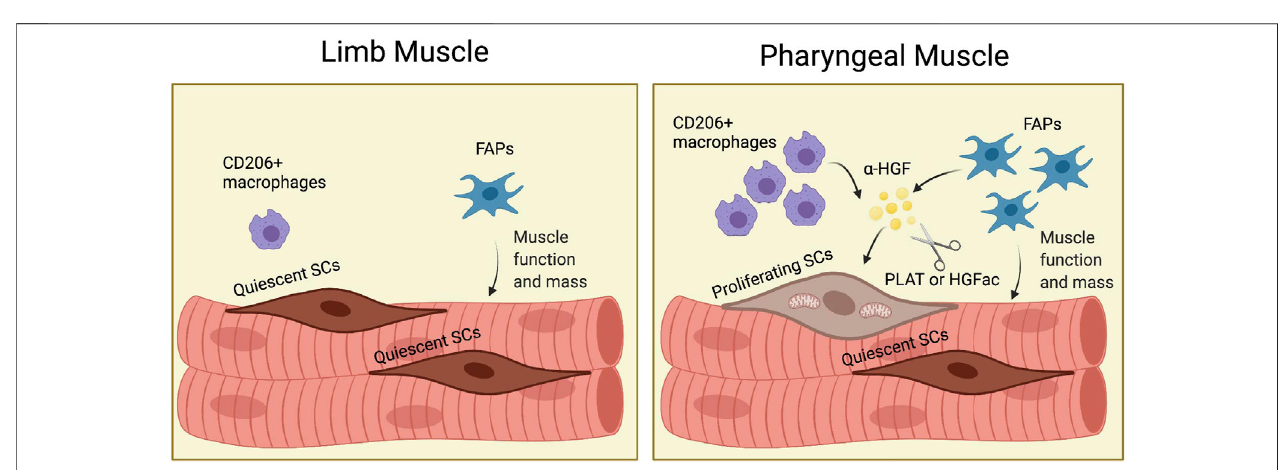
FIGURE 8 | (Graphic abstract). FAPs induce proliferation of pharyngeal satellite cells by HGF and maintain pharyngeal muscle mass and function. In pharyngeal muscles, the increased number of CD206 + macrophages and fi broadipogenic progenitors (FAPs) secrete HGF. HGF is converted to the active form ( α -HGF) by tissue- type plasminogen activator (PLAT) or HGF activator (HGFac). Therefore, FAPs mediate proliferation of SCs in pharyngeal muscles via HGF. In addition, FAPs maintain pharyngeal muscle mass and function. Created with BioRender.com.